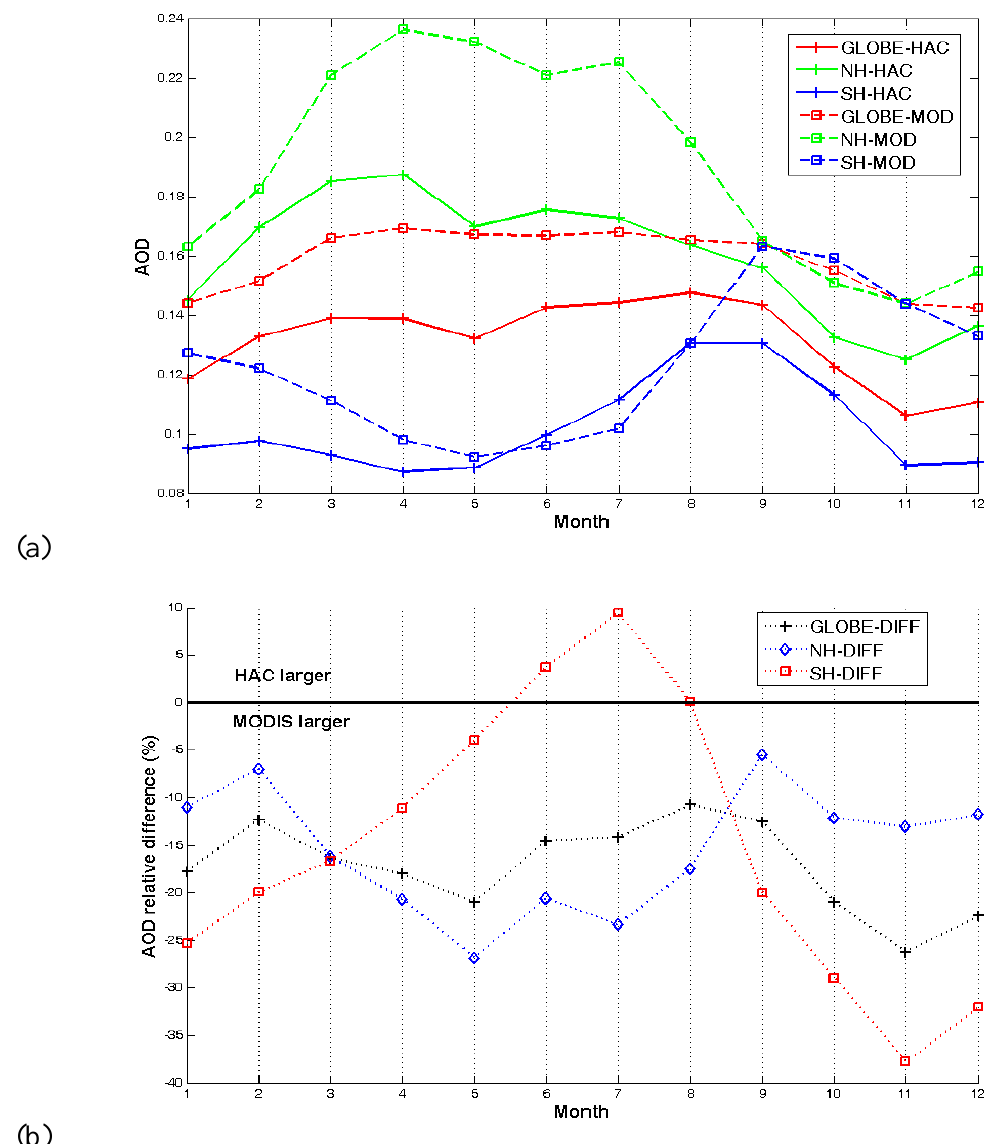
Figure 3. Intra-annual variation of: a) HAC and MODIS global and hemispherical monthly AOD and b) 2 Fig. 3. Intra-annual variation of (a) HAC and MODIS global and hemispherical monthly AOD and (b) HAC and MODIS global and hemi- HAC and MODIS global and hemispherical monthly AOD relative differences ([HAC-MODIS]/MODIS). 3 spherical monthly AOD relative differences ((HAC − MODIS)/MODIS). Note the negative scale on y axis in Fig. 3b. Values are for common Note the negative scale on y-axis in Fig. 3b. Values are for common grids. 4